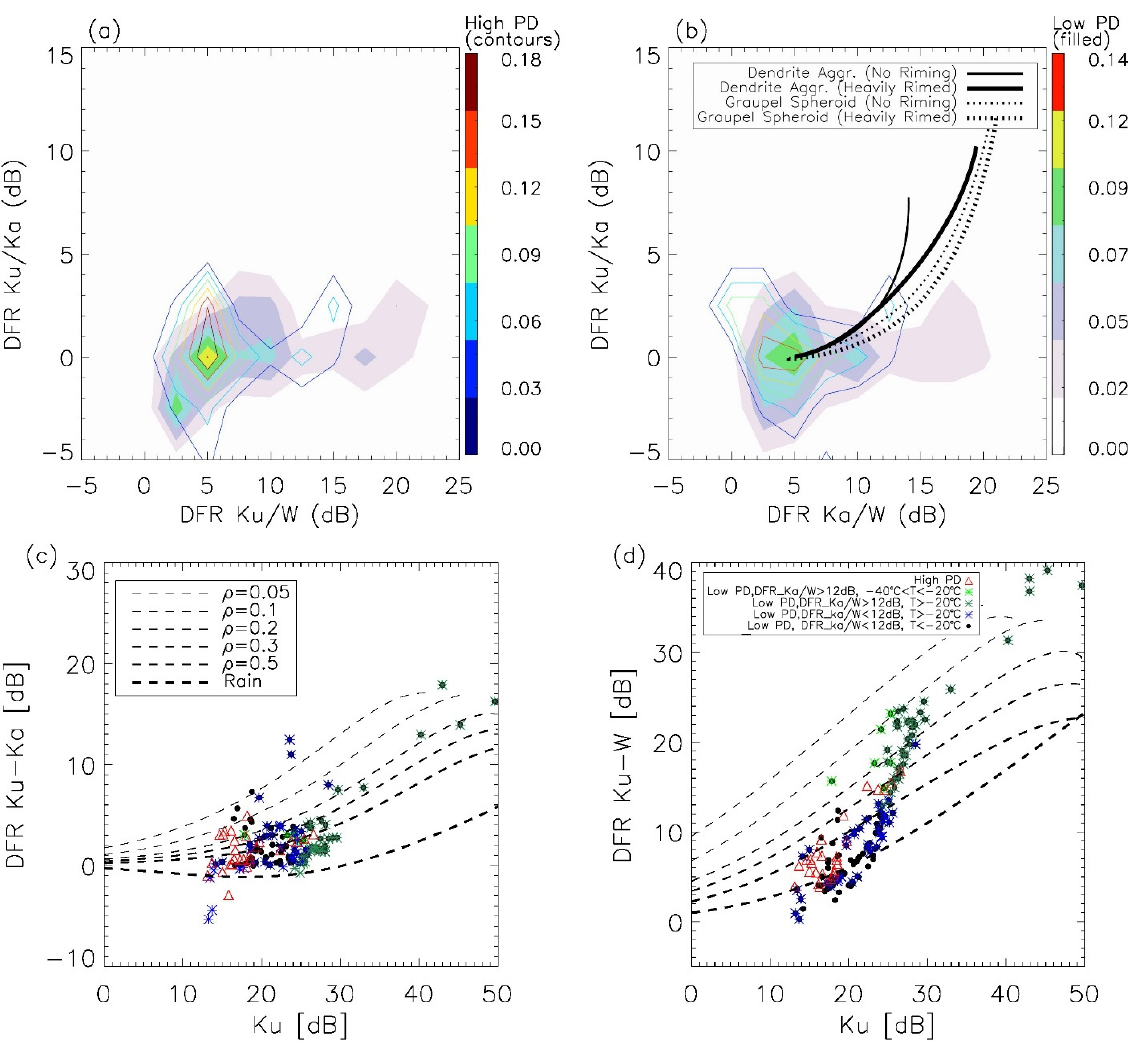
Figure 11. Adapted from Figures 6 and 7 from Gong et al. (2020). ( a ) The 2D-PDF of CloudSat-DPR collocated Ku/Ka-band DFR vs. Ku/W-band DFR for the “high-PD” (color contours, upper left panel color scale) and the “low-PD” (color shades, upper right panel color scale) scenarios on the triple-frequency diagram together with several theoretical calculated curves for four different ice shapes (black curves). ( b ) Same as ( a ) except the 2D-PDF of CloudSat-DPR collocated Ku/Ka-band DFR vs. Ka/W-band DFR is shown. ( c ) Scattergram of the CloudSat-DPR collocated Ku/Ka-band DFR vs. Ku-band reflectivity values on the theoretically calculated density isolines, each isoline denoted by the legend. ( d ) Same as ( c ) except the CloudSat-DPR collocated Ku/W-band DFR vs. Ku-band reflectivity values. In ( c , d ), the red triangles correspond to “high-PD”, and the other three symbols corresponding to “low-PD”, with different temperature and DFR Ka/W-band values, as identified in the legend for panel ( d ).